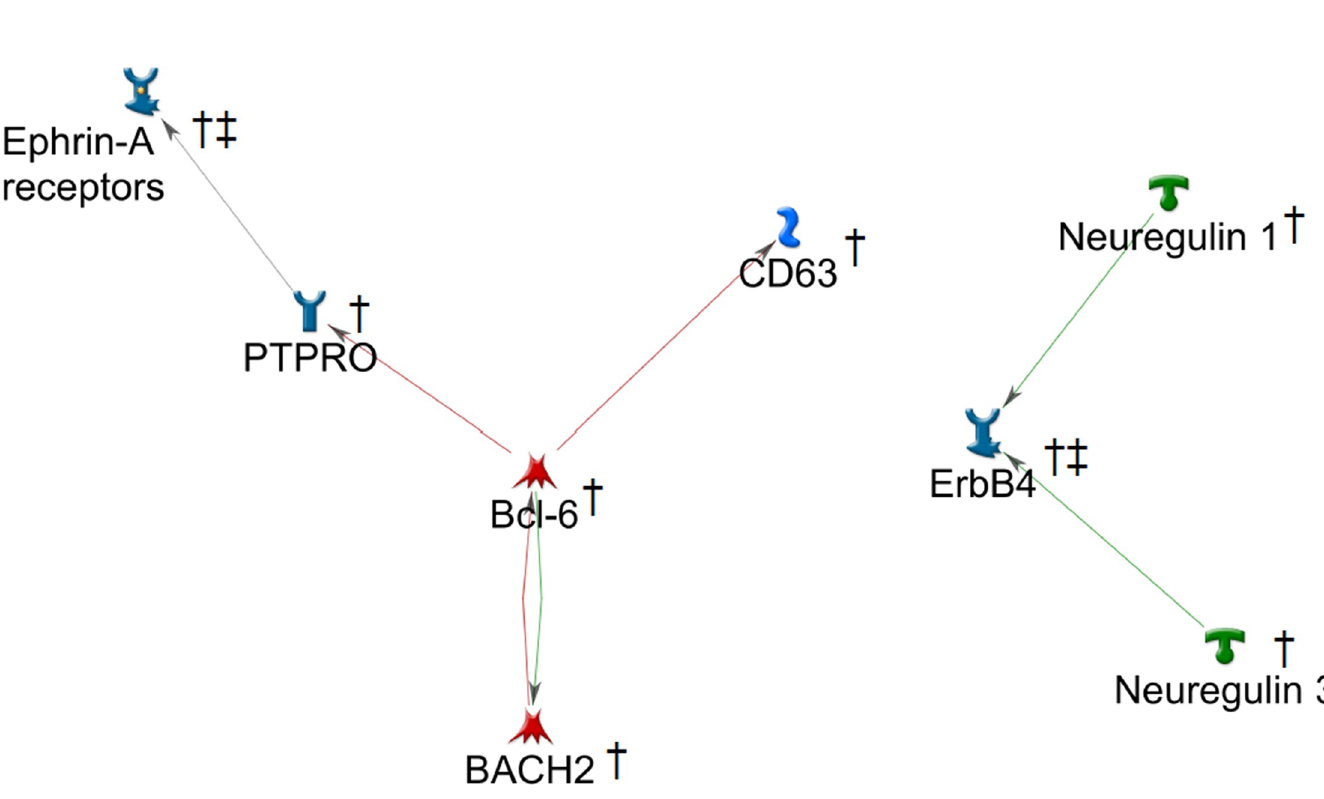
Fig 6. Two connected components among the 188 genes of high importance. †: associated with breast cancer, ‡: associated with radiation-induced carcinogenesis. The line colors indicate the activation (green), inhibition (red), and unspecified (grey) effect. Detailed legend is available at: https://portal.genego.com/legends/